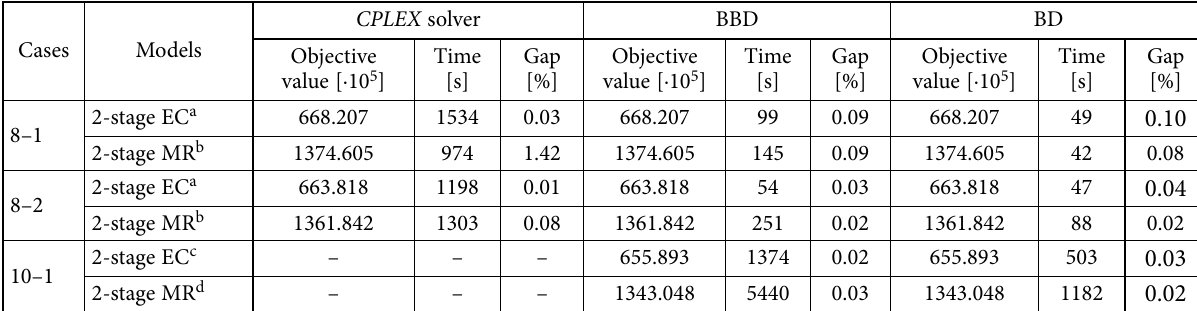
Table 7. Performance comparisons between